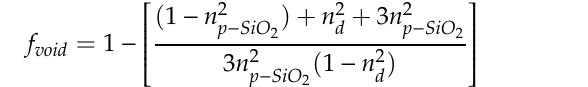
Table 1. Parameters determined from AFM and optical investigations for porous silica films.